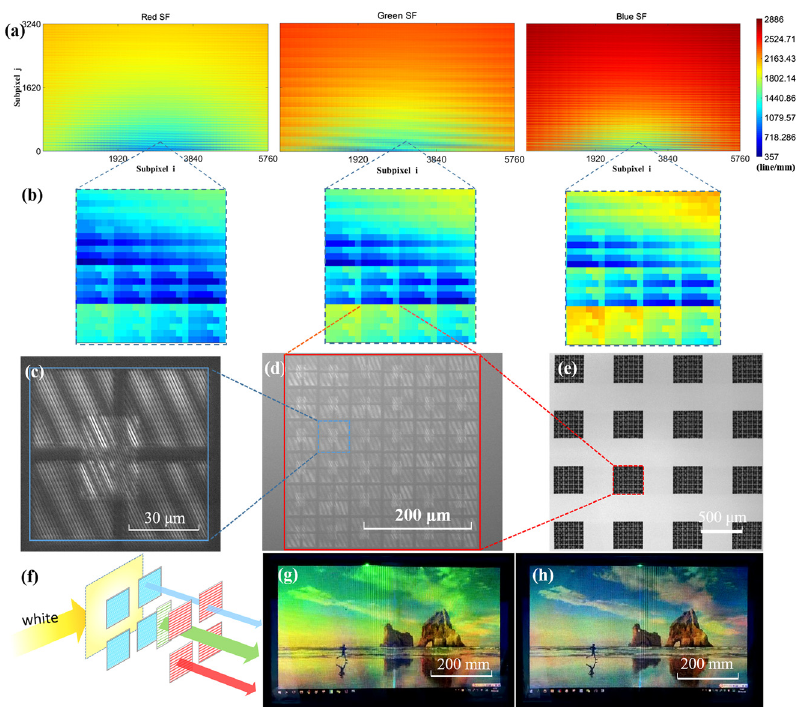
Figure 3: (a) The spatial frequencies of the metagratings for the central wavelength of 609, 540 and 456 nm are in the range of 357 ∼ 2157 line/mm, 414 ∼ 2502 line/mm and 477 ∼ 2886 line/mm, respectively. (b) The variation of spatial frequencies of the metagratings within a voxel for RGB color. (c) The SEM image of one subpixel with three layers of metagratings. (d) The SEM image of one pixel containing 36 subpixels. (e) The Microscopic picture of the holographic combiner. (f) The schematic diagram of spatial multiplexing. (g, h) Comparison between the image projected on monolayer metagrating and that on 3-layer metagratings with spatial multi-